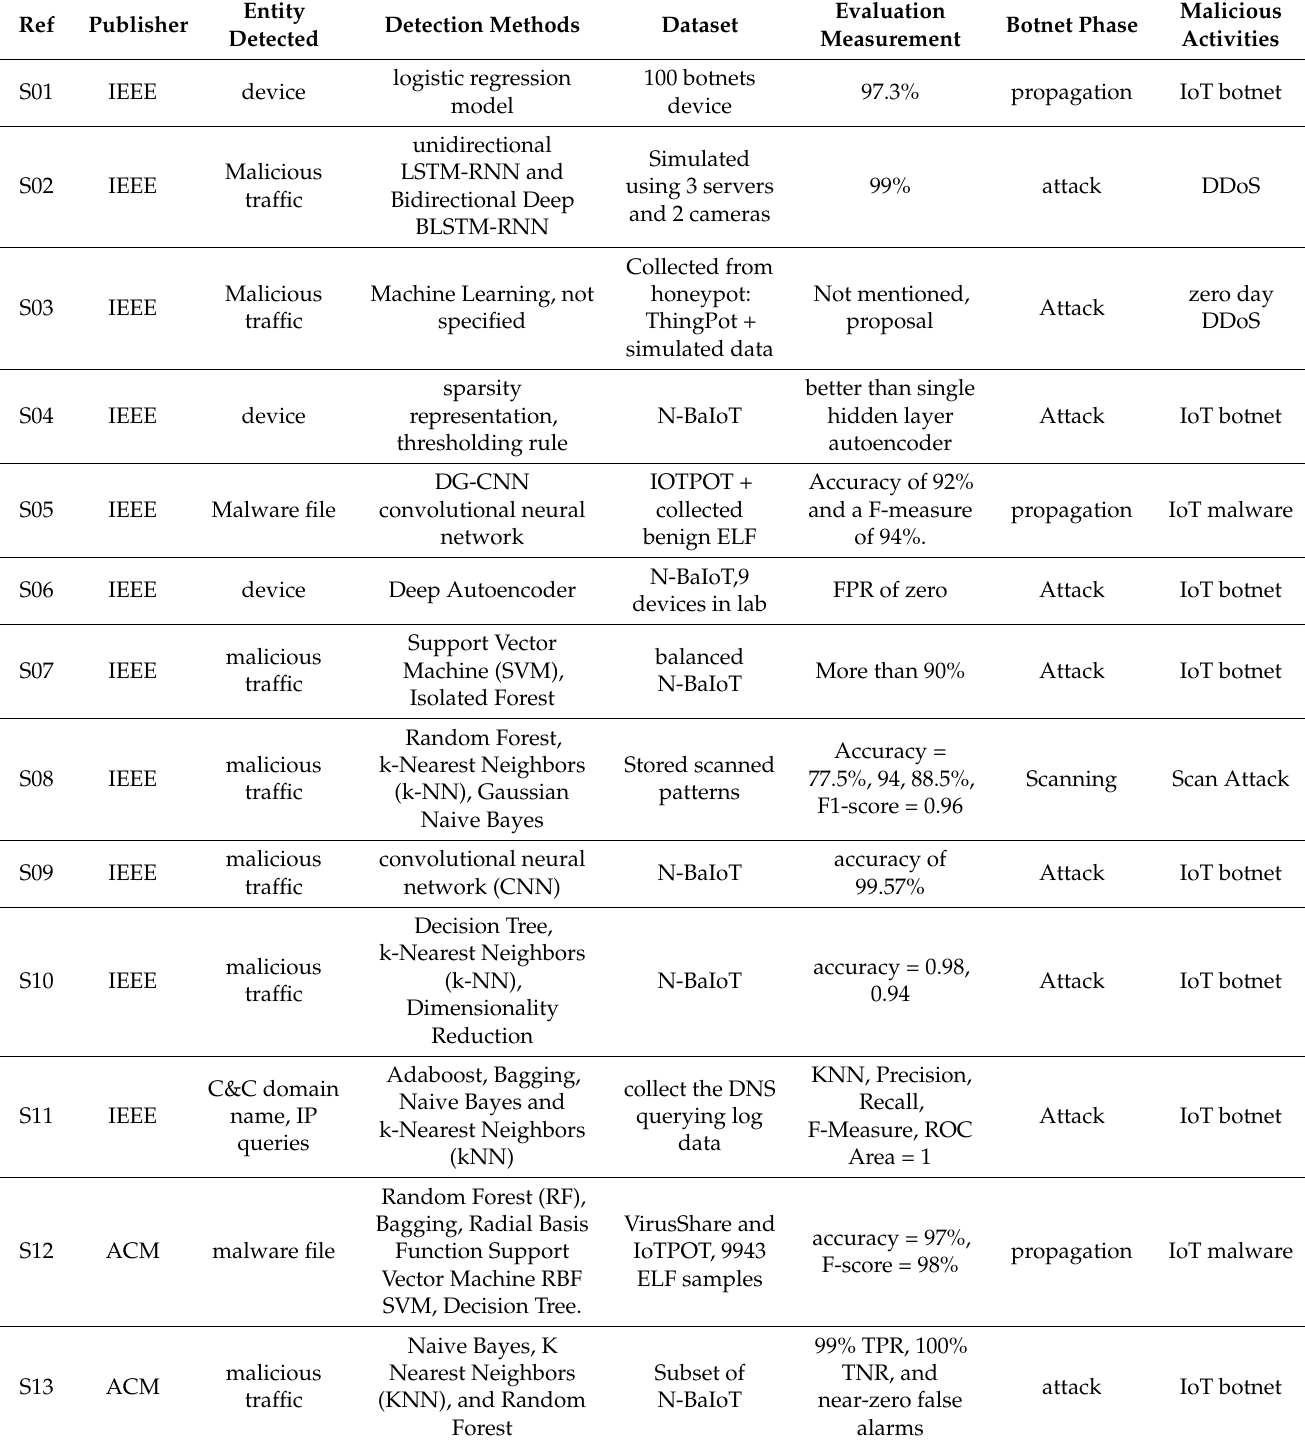
Table 8. A comparison of the methods used for the selected